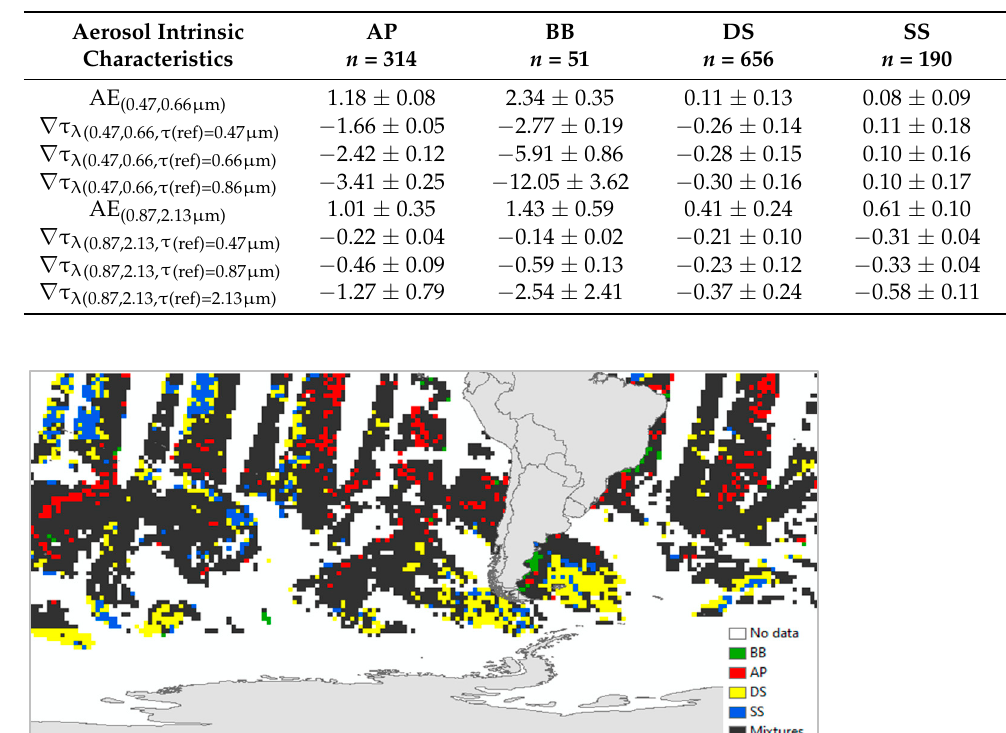
Table 5. Optical properties of various aerosol types extracted from MODIS daily aerosol products (MOD08_D3) on 25 August 2017.